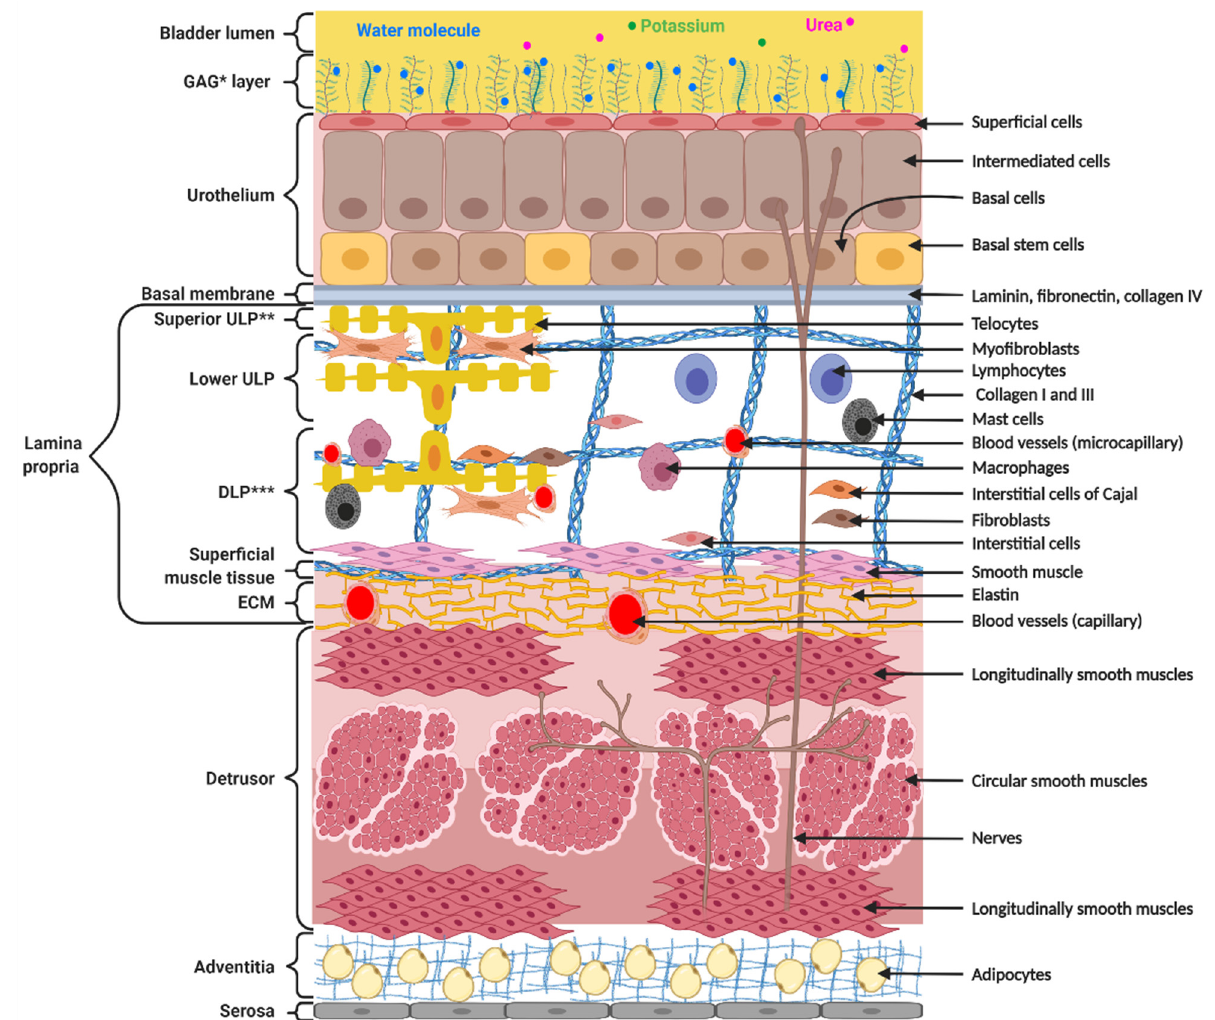
Figure 1. Structure and composition of the bladder wall. The bladder wall is composed of the urothelium, providing impermeability, the lamina propria, ensuring flexibility and compliance, the detrusor, allowing contractions, and the adventitia and serosa, protecting the bladder. * GAG = Glycoaminoglycan; ** ULP = upper lamina propria; *** DLP = deep lamina propria.